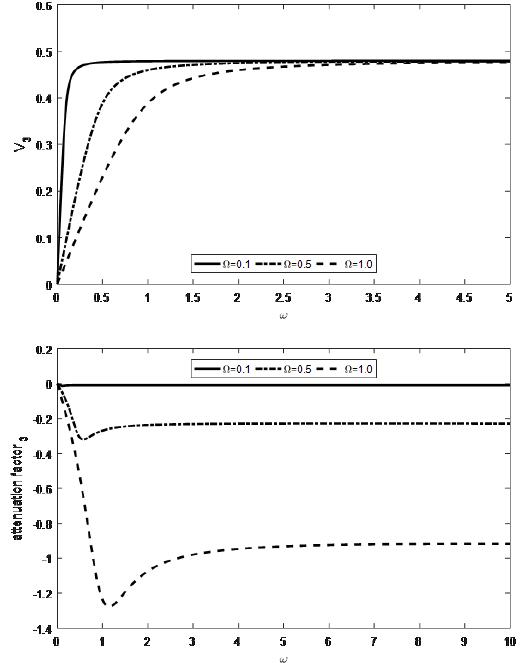
Figure 12: Velocity and attenuation factor for different values of ω and rotational